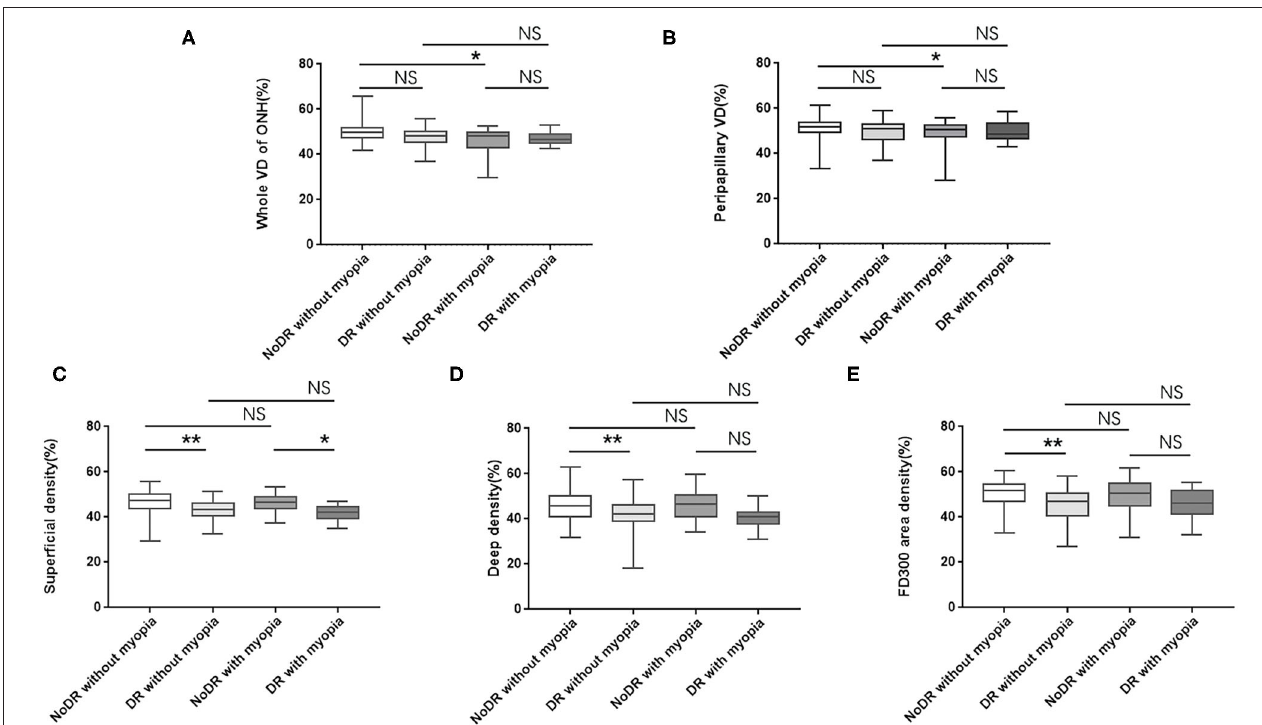
FIGURE 2 | Differences in VD of ONH and macula among subgroups (A–E) . VD, vessel density; ONH, optic nerve head; NoDR, diabetic eyes without diabetic retinopathy; DR, eyes with diabetic retinopathy; NS, no significant. * P < 0.05; ** P < 0.001. P < 0.05 were considered statistically